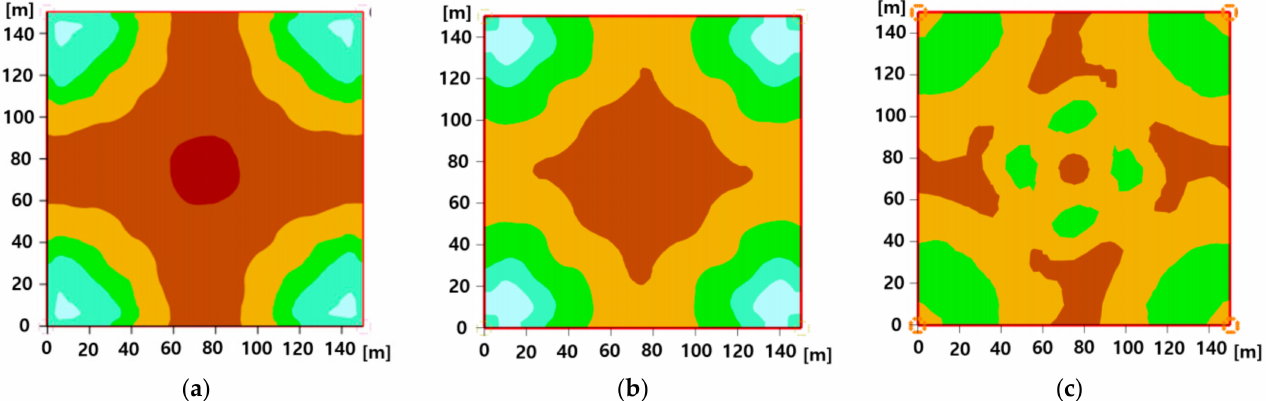
Figure 7. Simulation results of light distribution considering real dimension (150 m × 150 m) of seaport installation: commercial metal halide luminaire ( a ), commercial high-pressure sodium luminaire ( b ), and fabricated prototype LED luminaire ( c ).